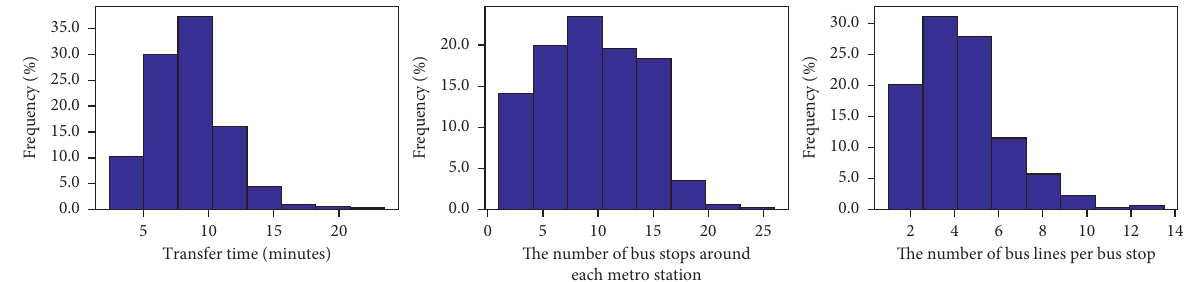
Figure 9: Frequency distribution histogram of three